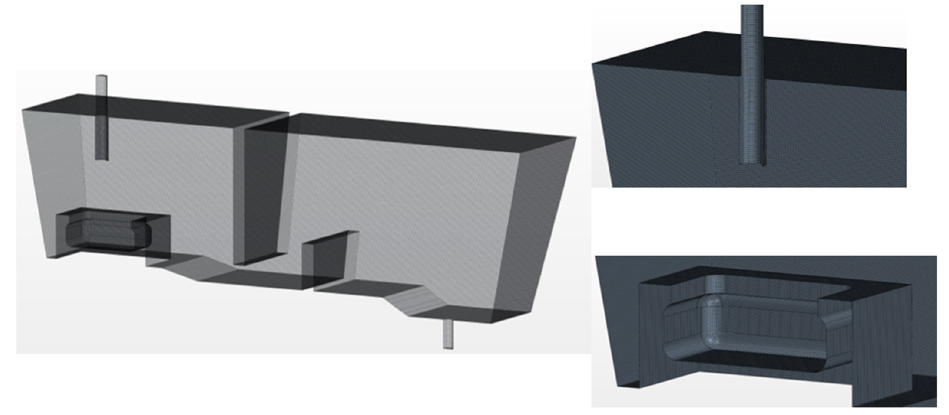
12 of 20 Figure 8. Comparison of measured RTD curves between two cases: WG and TI + WG (Theoretical residence time = 834 s). 3.2. CFD Model of Prototype Tundish 3.2.1. Validation of CFD Model Best practice guidelines (BPG) are important to ensure the accuracy and credibility